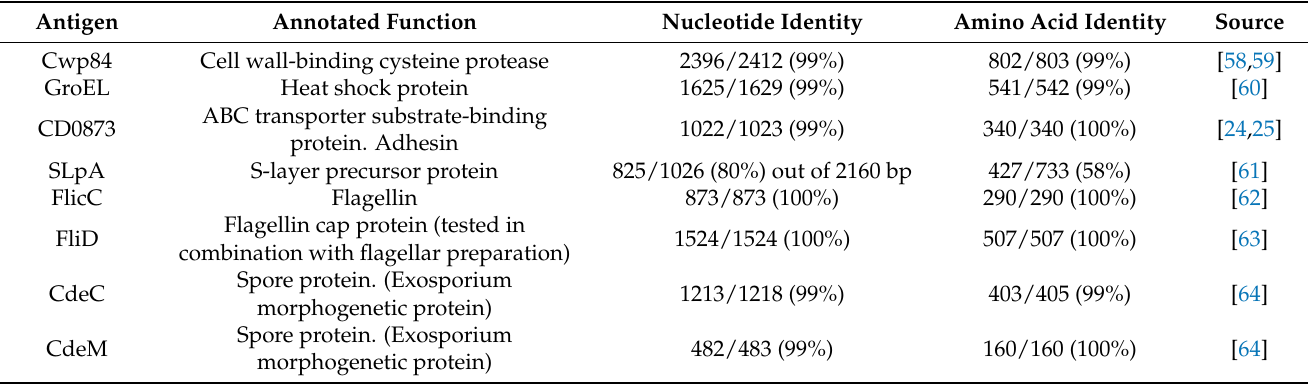
Table 1. Identification of homologues of TCD antigens in NTCD T7 that have shown some protection from either colonisation or infection in animal models. The percentage nucleotide and amino acid identity of these antigens with TCD strain 630 is